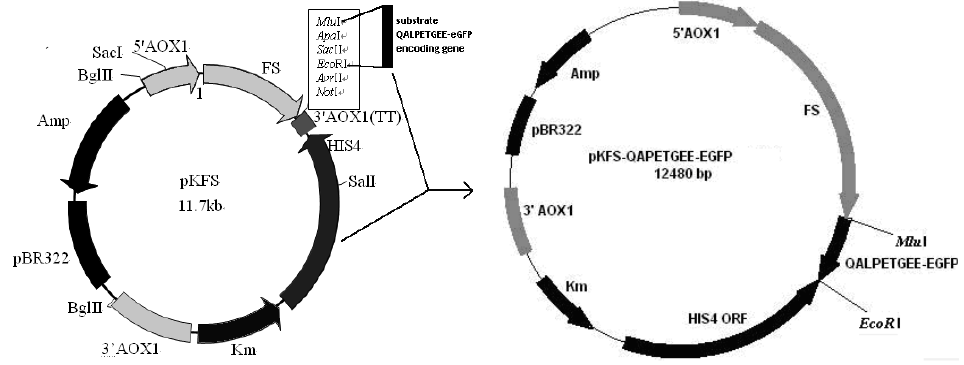
Figure 1. Construction of plasmid pKFS-LPETG.